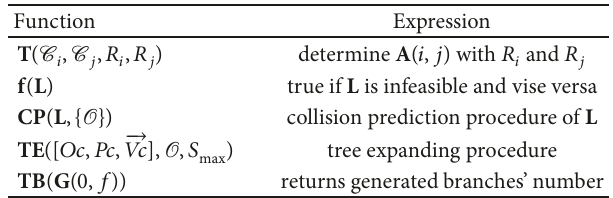
Table 3: Function definition in Algorithm